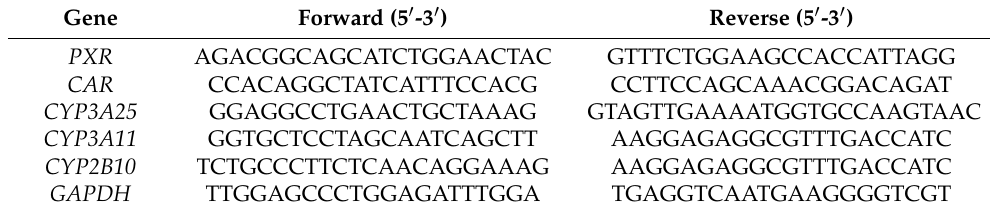
Table 1. Quantitative real-time PCR